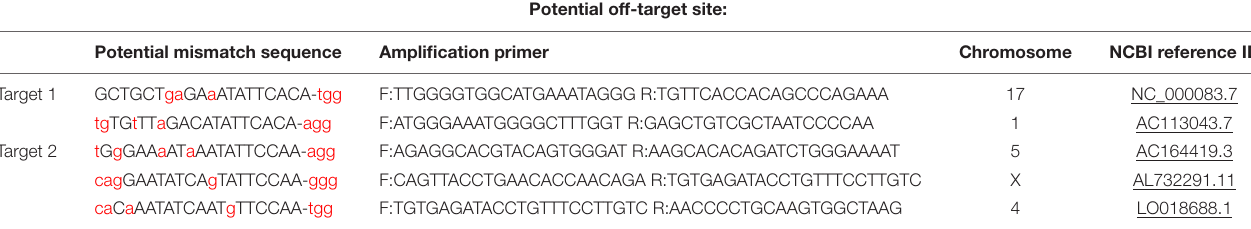
TABLE 2 | The potential off-target site and their amplification